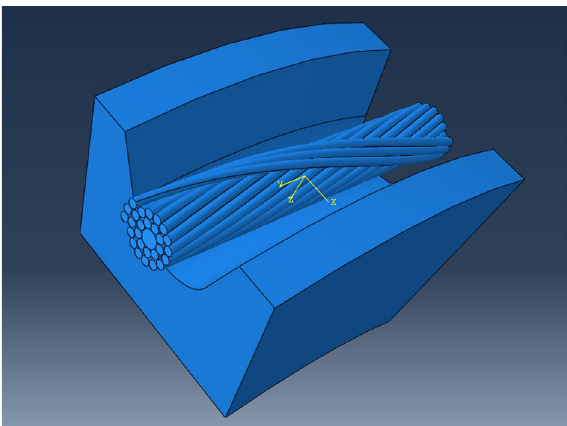
Figure 17. Finite element model of the conductor passing through pulley in the